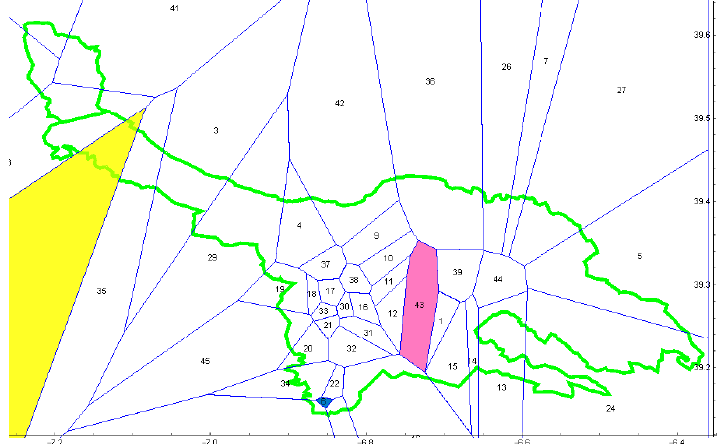
Figure 3. In yellow, Voronoi cell with the largest area (outside our area of interest). In blue the smallest one (26.2116 Ha) and in pink the largest one inside our study area (891.306